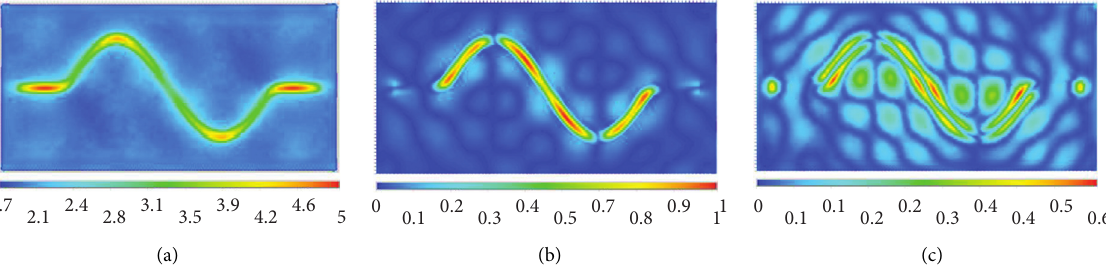
u u x , (b) y , and (c) z